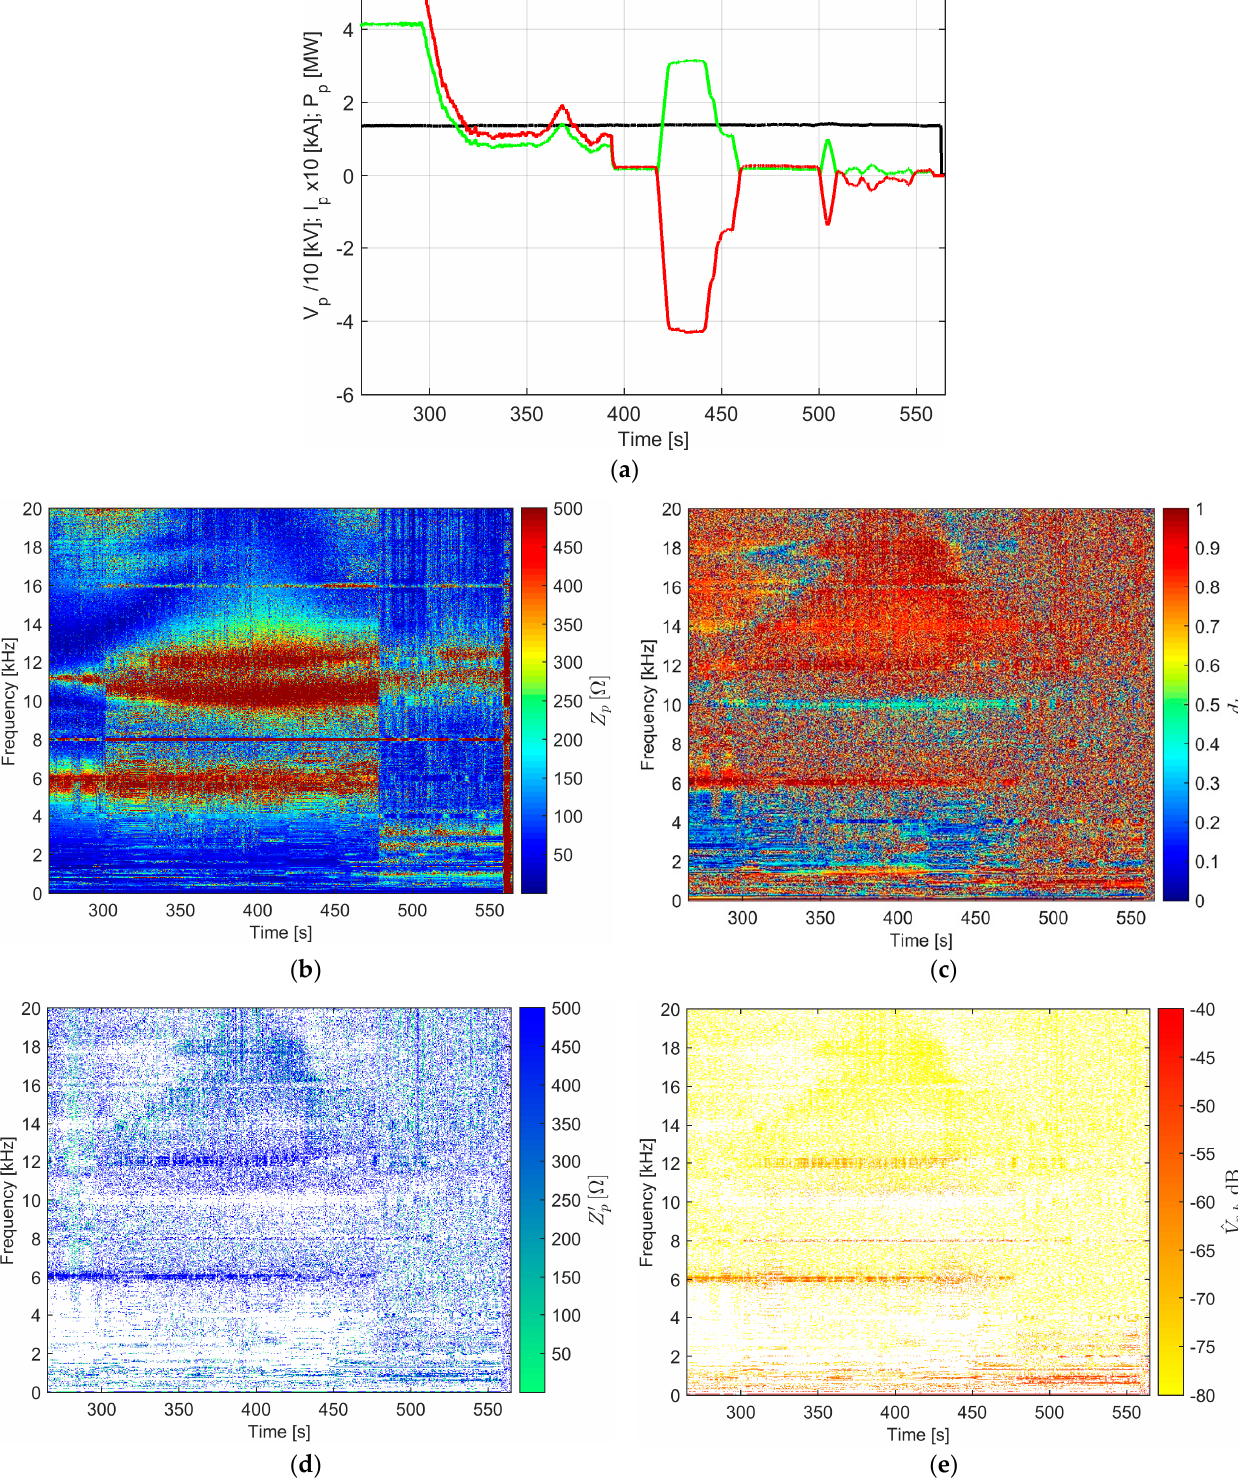
Figure 4. Switzerland example with zoom of time-varying anti-resonance: ( a ) voltage (black), current (green), and active power (red) profiles; ( b ) harmonic impedance Z p ; ( c ) harmonic active power P h ; ( d ) filtered impedance Z ′ p ; ( e ) normalized harmonic voltage ˆ V p , h